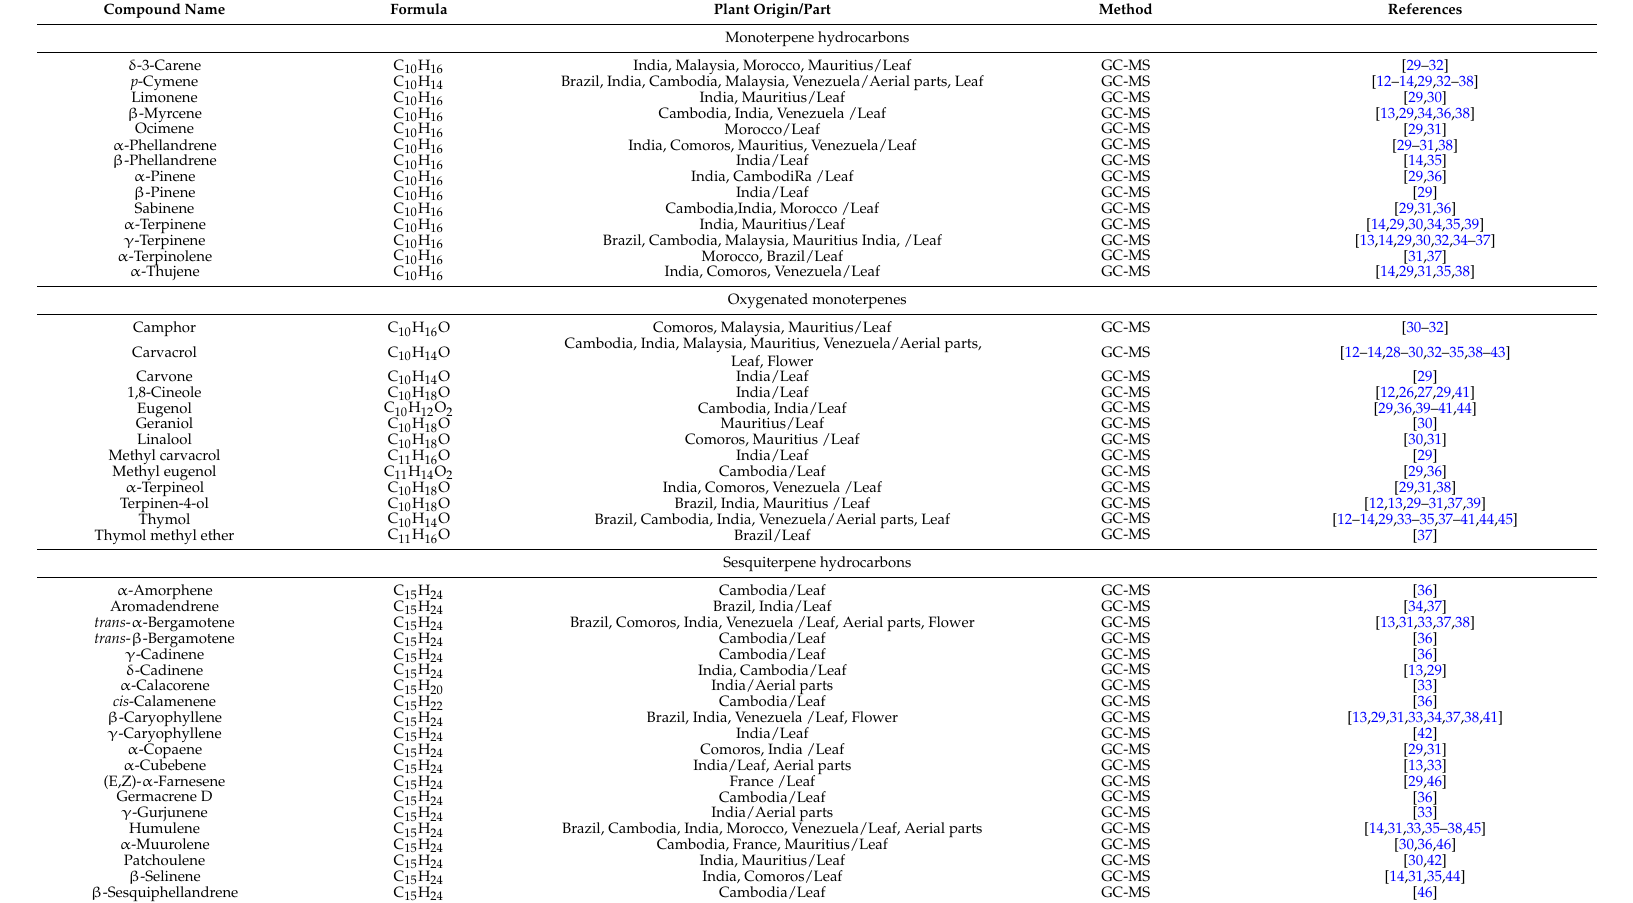
Table 2. The known volatile constituents of P.